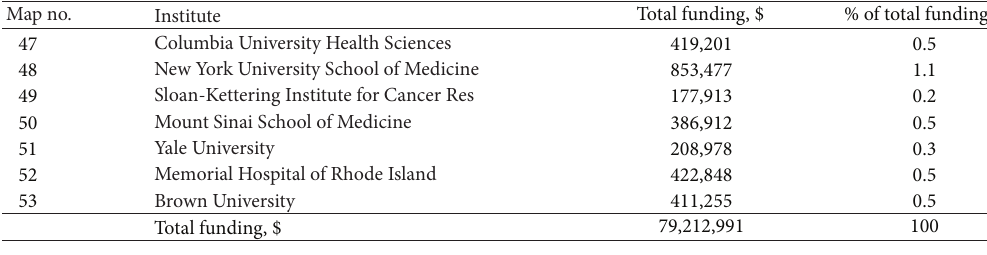
Figure 3: (a) Geographical distribution of institutions receiving project funding, (b) Legend for Figure 3(a).